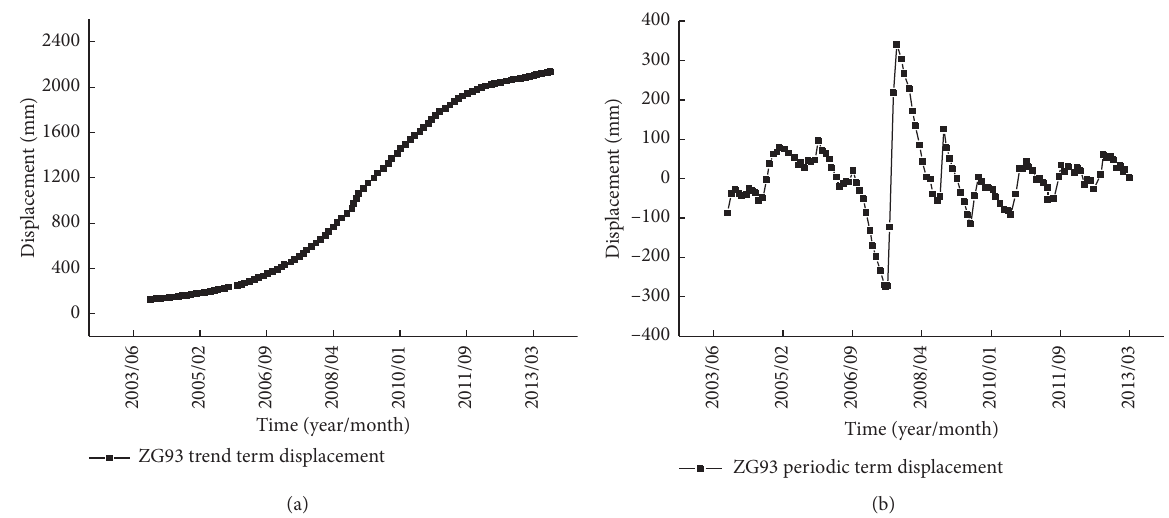
Figure 6: Results of wavelet analysis: (a) the trend component displacement after decomposition; (b) the periodic component displacement after decomposition.